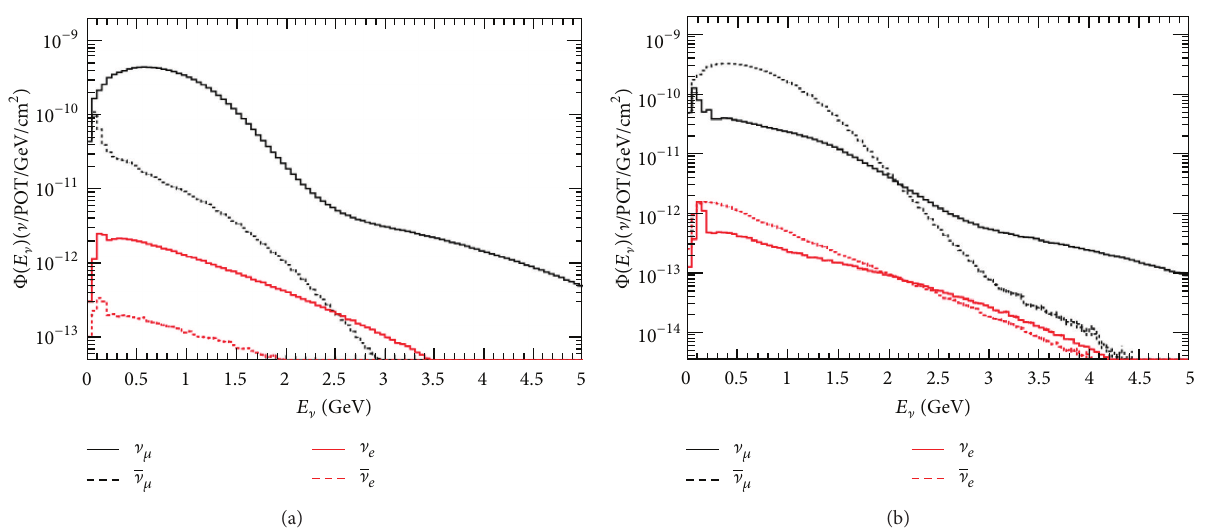
Figure 11: The estimated MiniBooNE neutrino fluxes for neutrino mode (a) and antineutrino mode (b).